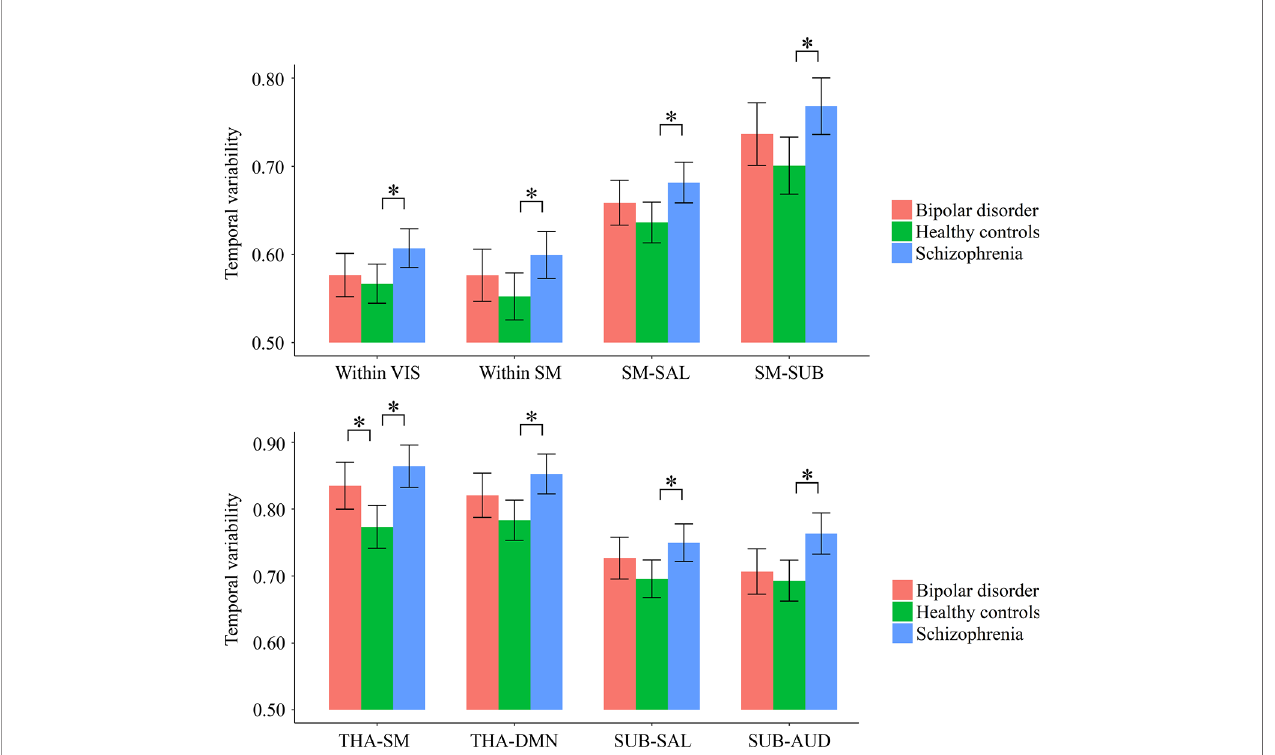
FIGURE 3 | Group differences in the temporal variabilities of intra-network and inter-network FC patterns. The error bars present the 95% con fi dence intervals, and the marks “ * ” indicate signi fi cant between-group differences with corrected p < 0.05. AUD, auditory network; DMN, default mode network; FC, functional connectivity; SAL, salience network; SM, sensorimotor network; SUB, subcortical network; THA, thalamus; VIS, visual network.